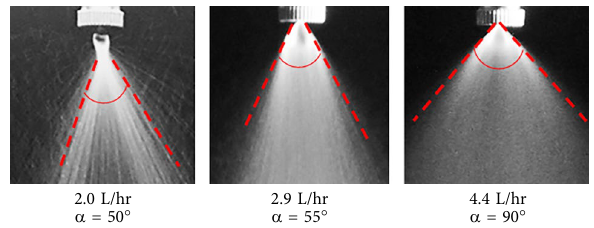
Figure 5. Nozzle spray angle for various flow Table 2. Upper and lower wetness limits for various outfits